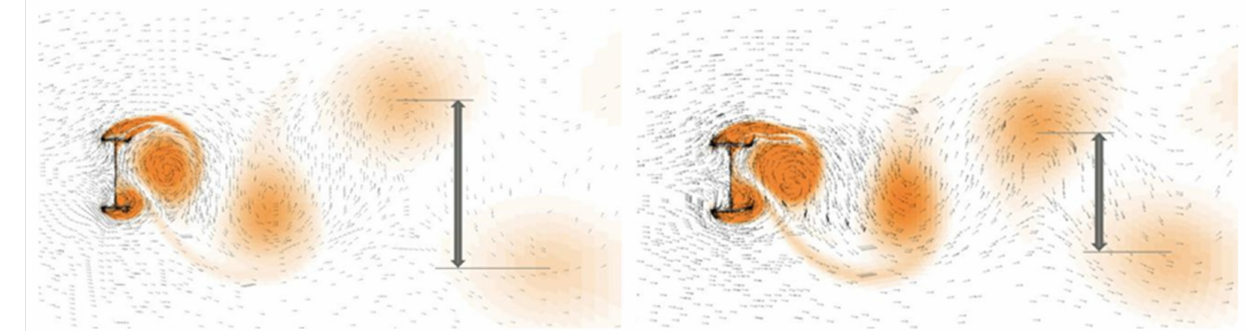
Figure 7. Vorticity contour at a particular moment of the single beam simulations in free flow, with h = 3 m ( left ) and h = 2 m ( right ). The change in wake’s width concerning the beam height can be observed (double column, B&W in the printed version).